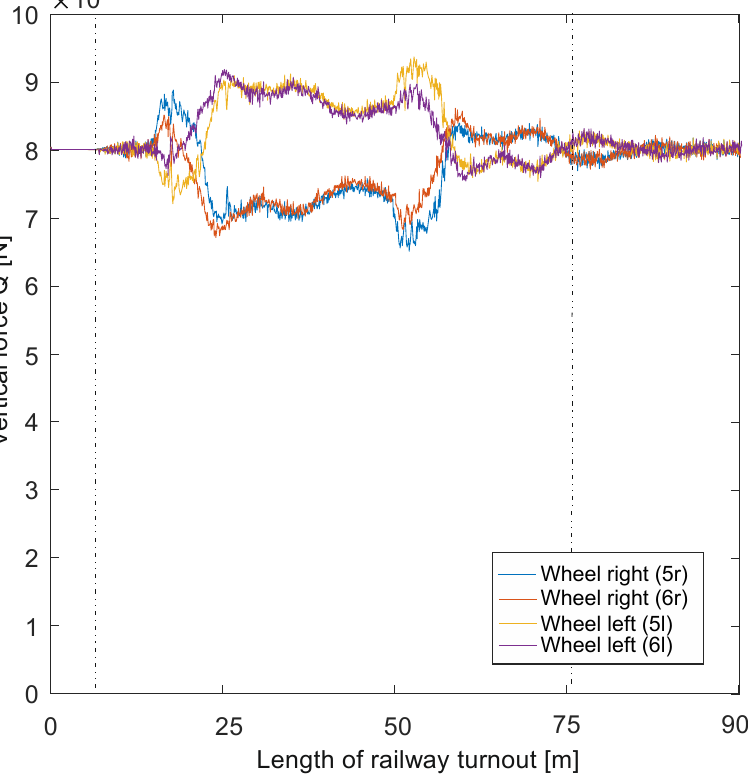
Figure 8. Vertical force on wheels at 200 km/h on a straight track through a turnout.